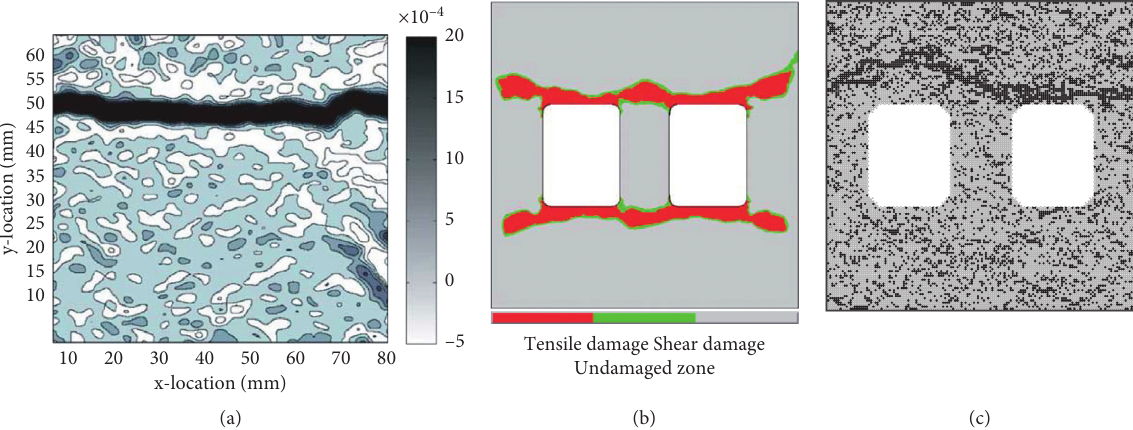
Figure 11: Strain map and damage behavior of double-aggregate specimens under postpeak tension: (a) strain map in [36]; (b) damage behavior in [5]; (c) damage behavior in this